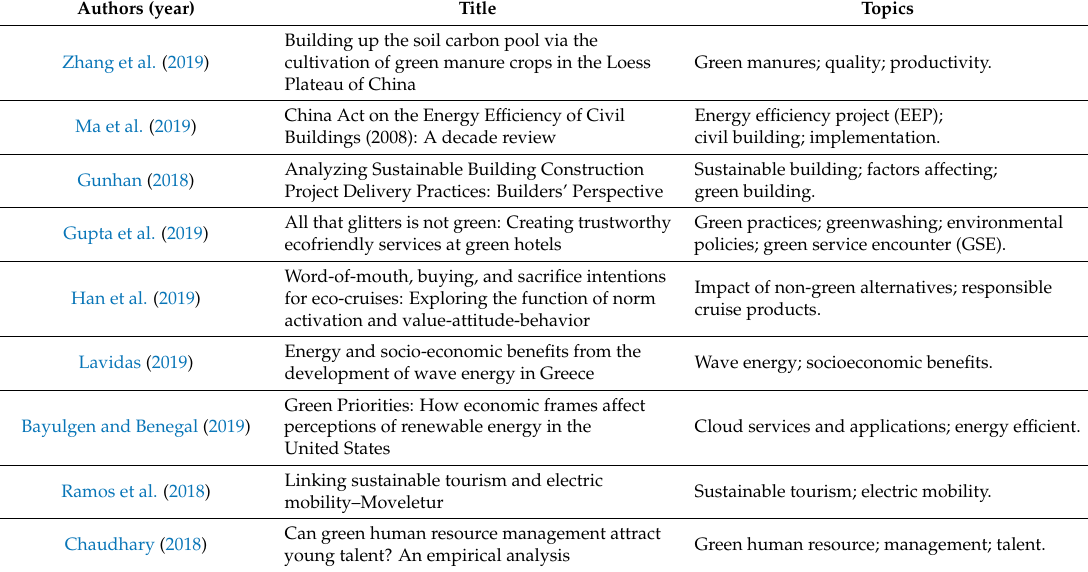
Table 4. The most recent